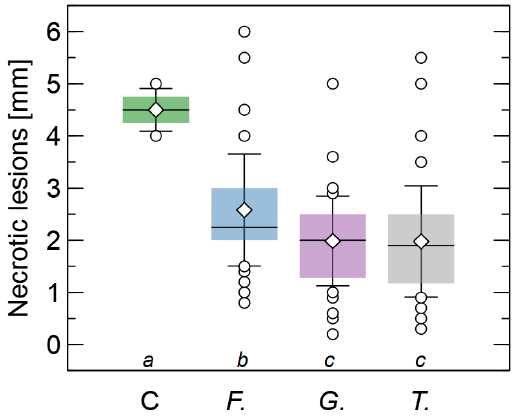
Figure 2. Necrosis length for various extracts: C–control, F. – Fomitopsis pinicola , G. – Ganoderma applana- tum , and T. – Trametes versicolor . Treatments, for which statistically significant difference at p < 0.05 was found using Tukey’s multiple comparisons test, are marked by different characters in the bottom part of the chart.